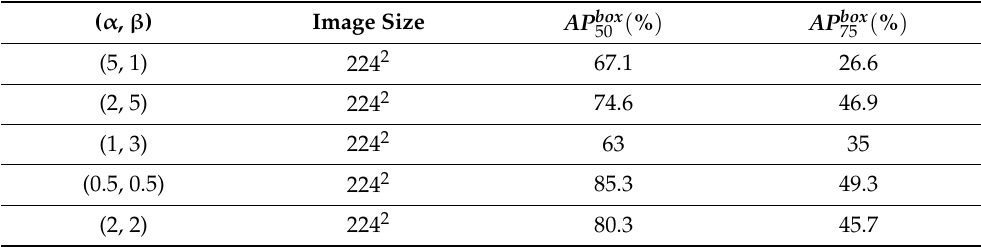
Table 1. The average accuracy of the Swin-HSTPS when MixUp varies with the value of ( α , β ).